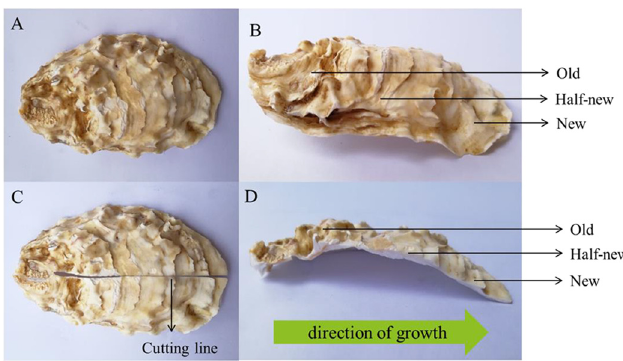
Fig. 4. The direction of shell growth. “ Old ” represents the earliest secreted shell. “ New ” represents the shell that has been secreted most recently. “ Half-new ” represents the shell produced between the earliest and most recent shell structures.